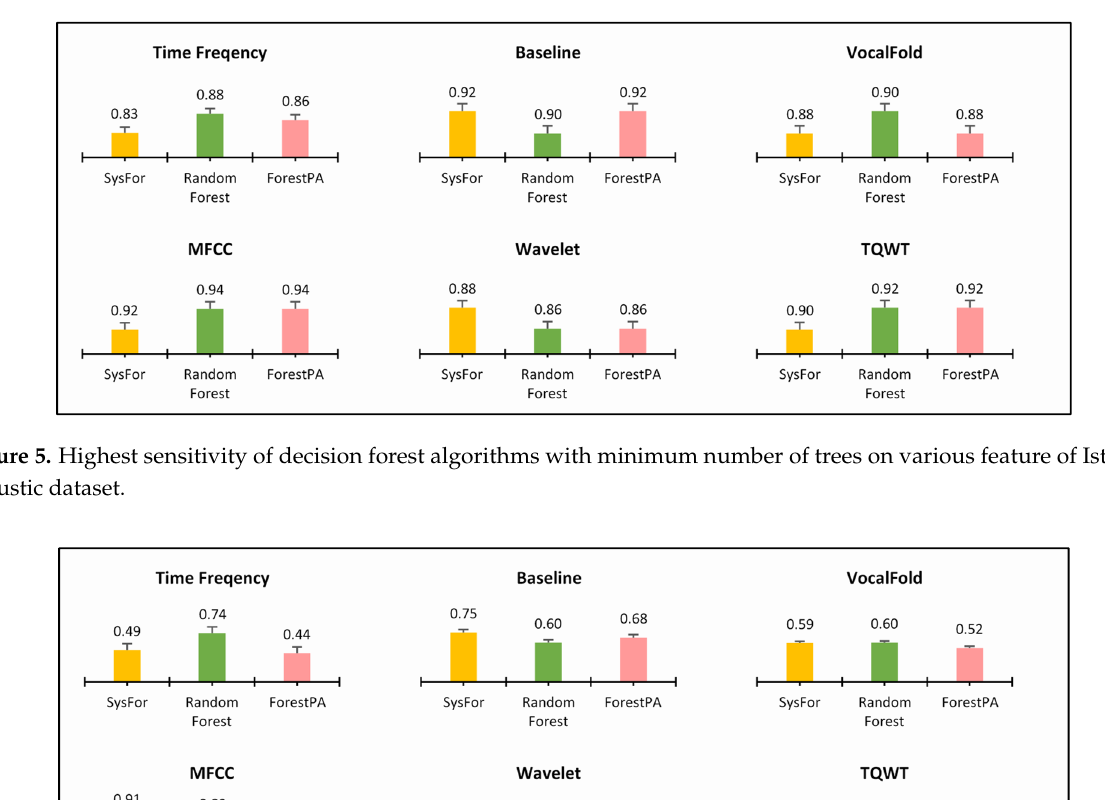
Figure 4. Highest detection accuracy of decision forest algorithms with minimum number of trees on various feature of Istanbul acoustic dataset.